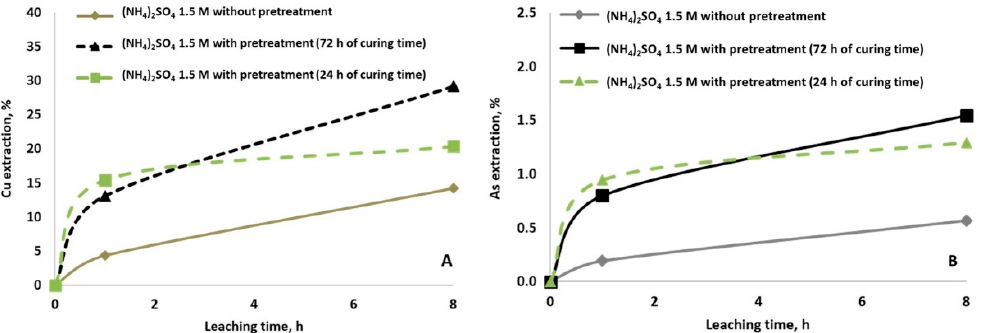
Figure 4. Copper ( A ) and arsenic ( B ) extraction at ambient condition using 1.5 M of (NH 4 ) 2 SO 4 without and with pretreatment (15 g/L of NaCl and curing time of 24 h and 72 h).